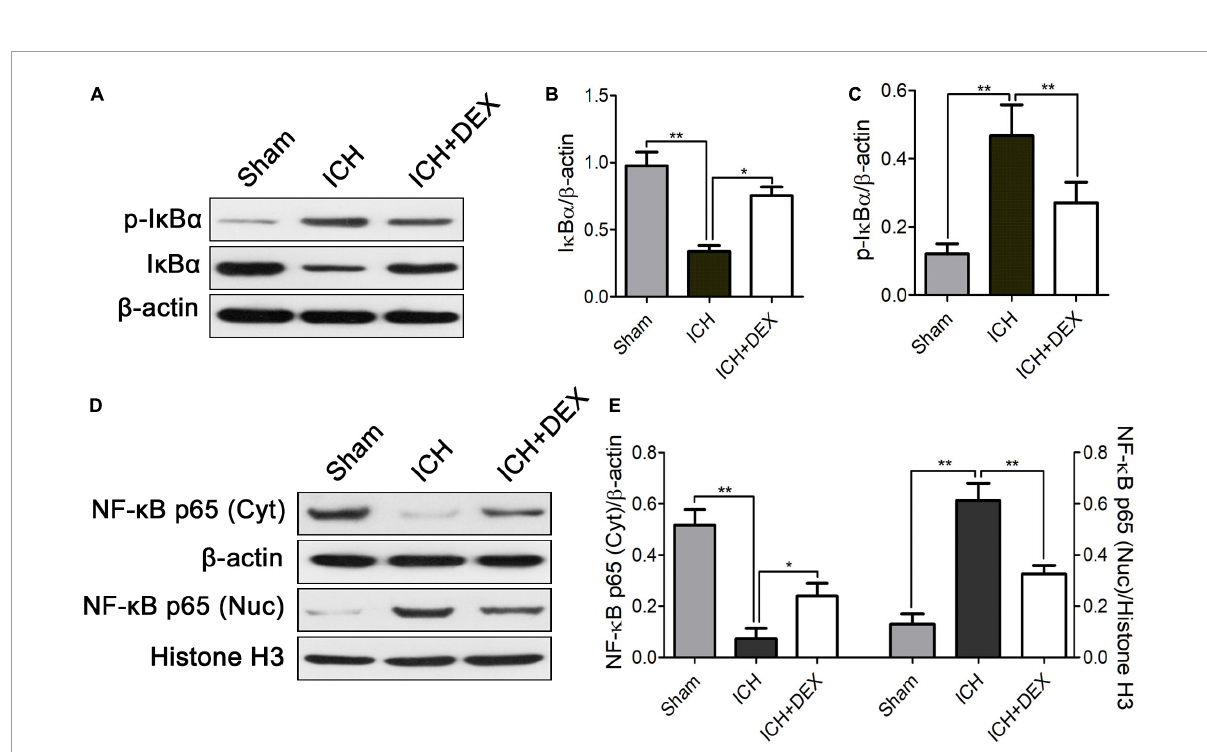
FIGURE6 On the 3rd-day post-ICH, (A) representative Western blot expressions of I κ B α and p-I κ B α . (B,C) The protein expression of I κ B α was significantly decreased with an increase in p-I κ B α in the ICH group compared with those of the sham group. DEX caused marked dephosphorylation of I κ B α . (D) Representative Western blot expressions of NF- κ B. (E) Translocation of NF- κ B p65 into the nucleus occurred after ICH. DEX significantly blocked the translocation. * p < 0.05, ** p < 0.01. Scale bar = 50 µ